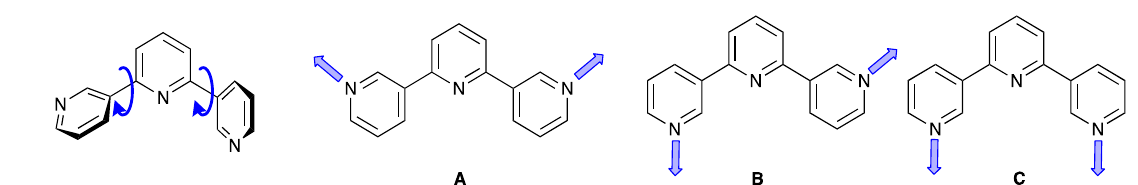
Scheme 4. Some isomers of tpy are conformationally flexible, for example, rotation about the inter ‐ ring C–C bonds in 3,2’:6’,3” ‐ tpy leads to three planar conformers.